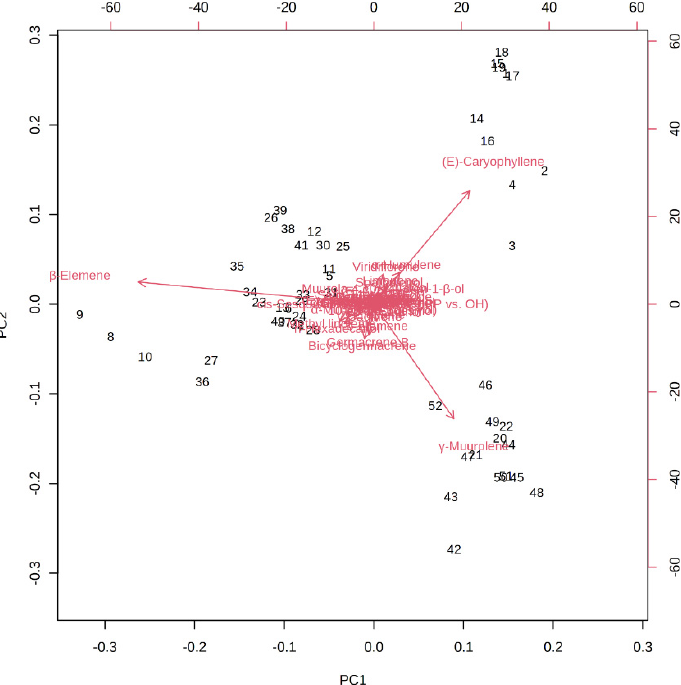
Figure 6. Loadings plot between the selected PCs (PC1 vs. PC2) showing the involvement of major essential oil components (>1%) in the grouping of M. champaca accessions. ( A ) PCA; ( B ) PLS ‐ DA.